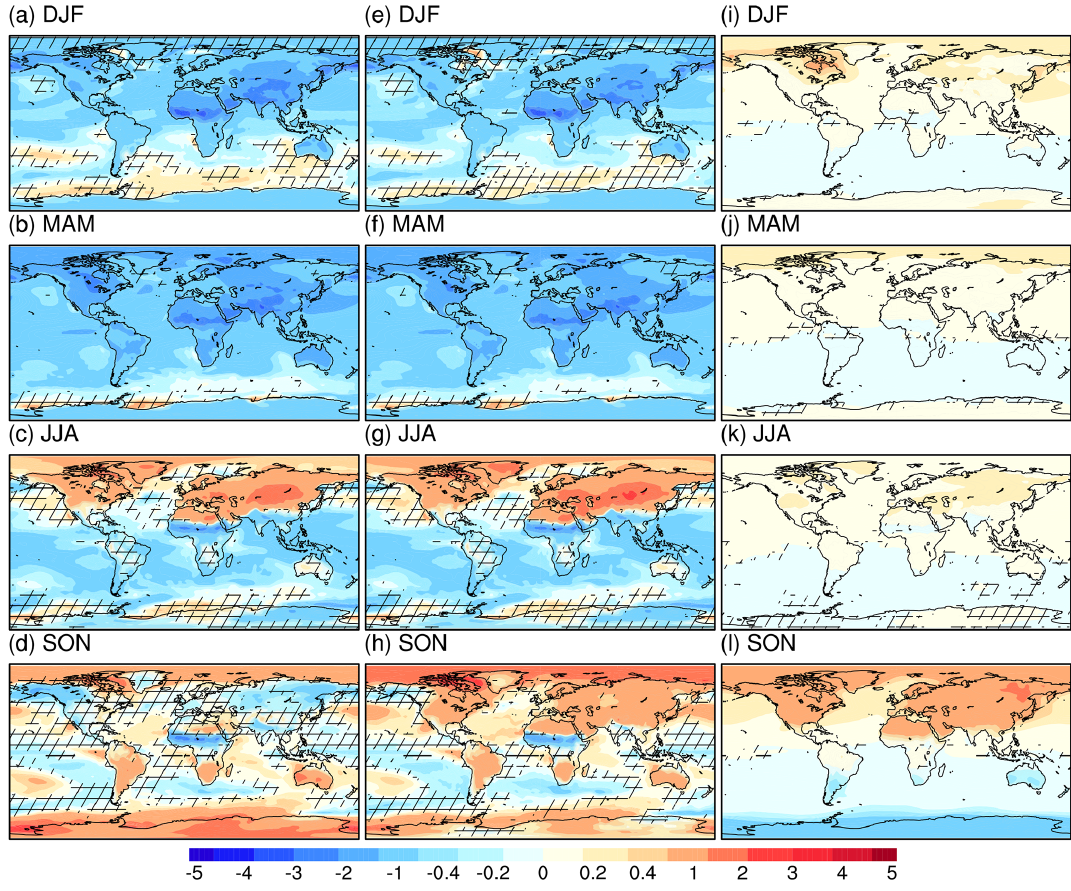
Figure 4. As Fig. 3, but for the